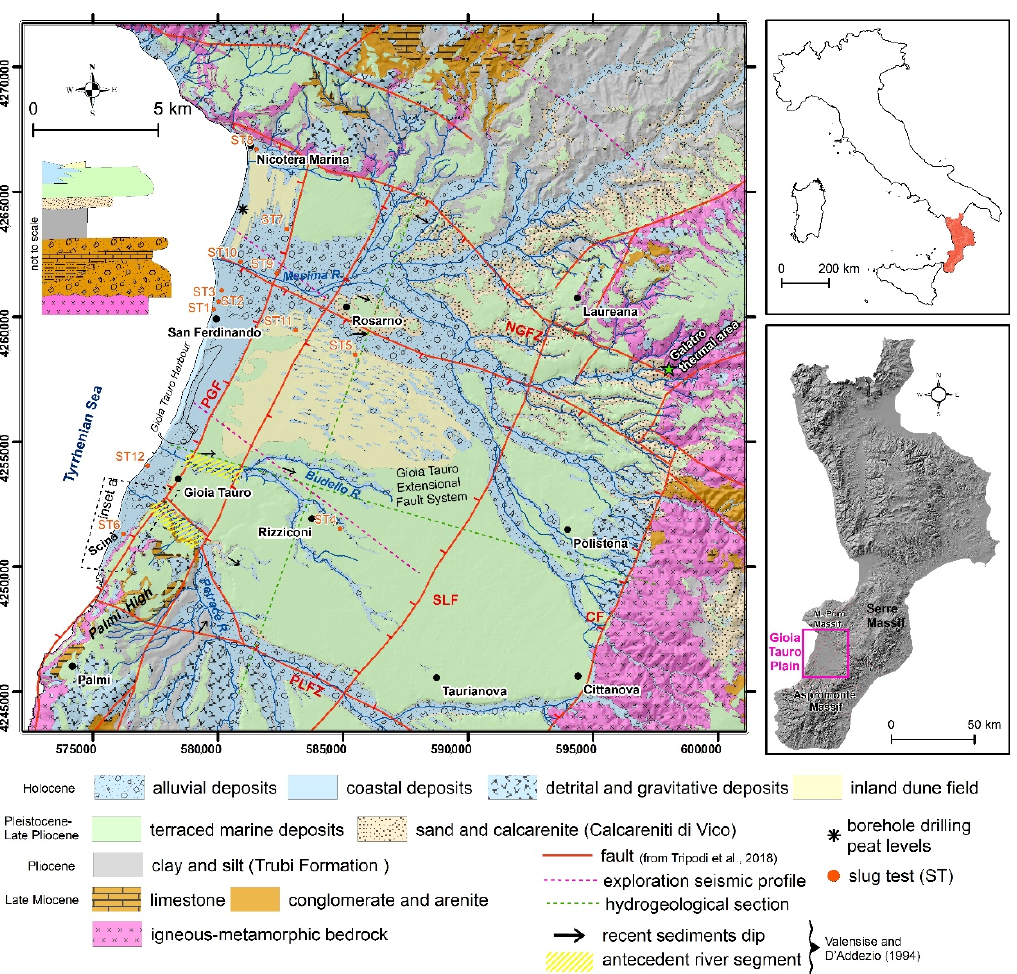
Figure 1. Simplified geological and structural map of the Gioia Tauro Plain. The map also reports a simplified stratigraphic column (not to scale) of the study area.